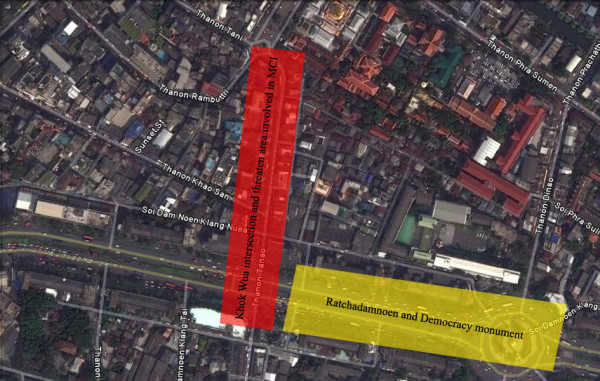
Map demonstrating MCI April 10, 2010. Red bar demonstrates most critical area in this MCI, while yellow bar shows second most common area occurred in MCI.